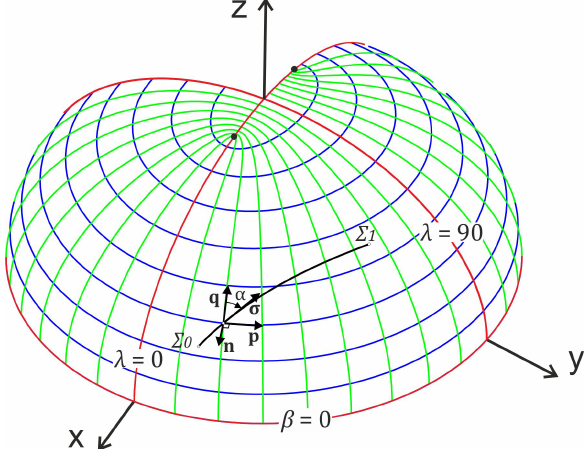
Figure 1: Unit vectors to a geodesic through a point Σ on a triaxial el- lipsoid: σ tangent to the geodesic, n normal to the triaxial ellipsoid, p tangent to the line of constant β , q tangent to the line of constant λ